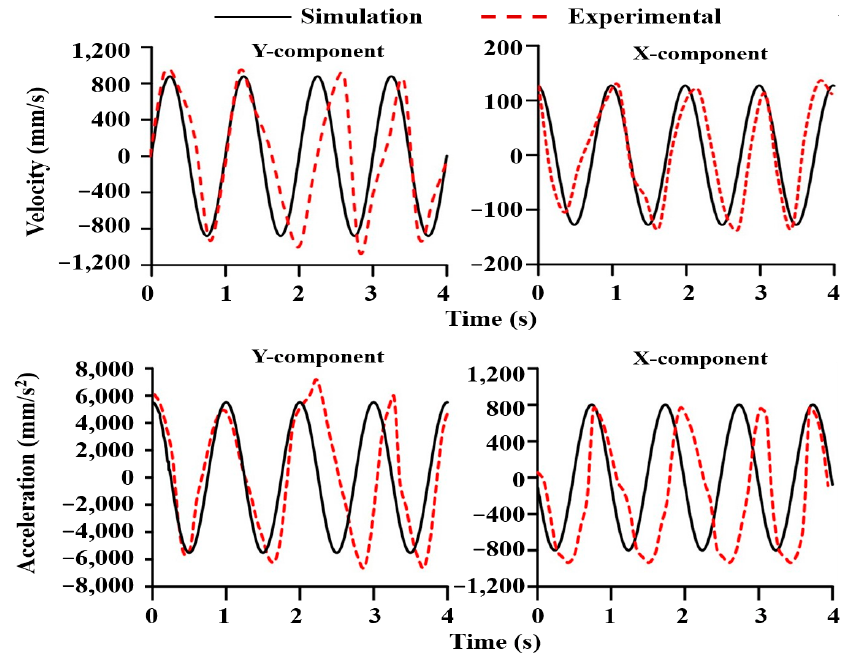
Figure 11. Simulated and experimental velocity and acceleration curves in the x- and y-axis direc- tions.